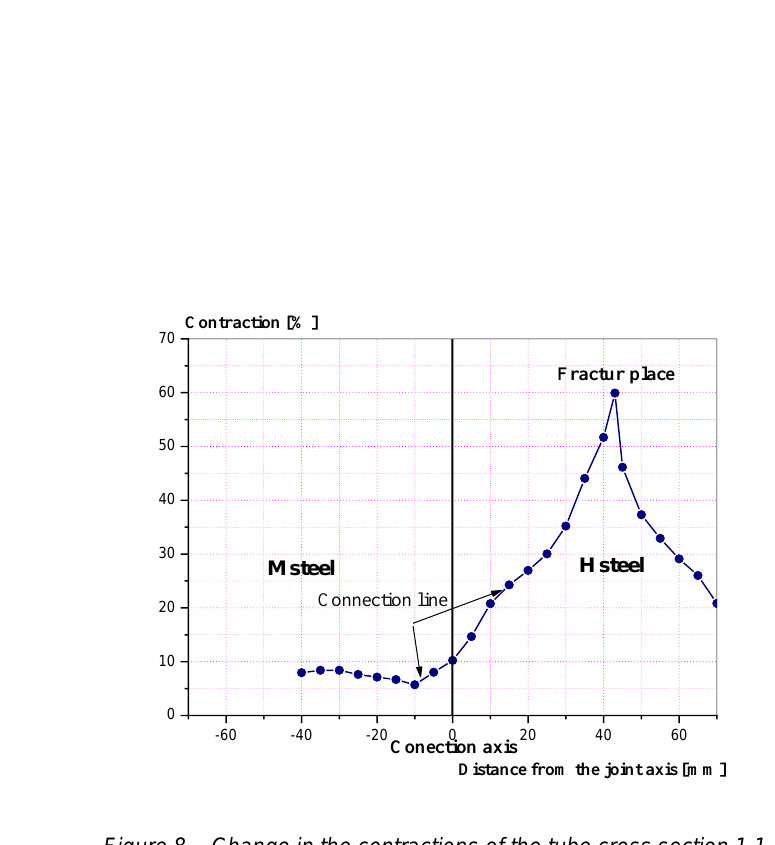
Figure 8 – Change in the contractions of the tube cross section 1.1 Рис. 8 – Изменение сужений поперечного сечения эпроветки 1.1 Слика 8 – Промена контракција попречног пресека епрувете 1.1